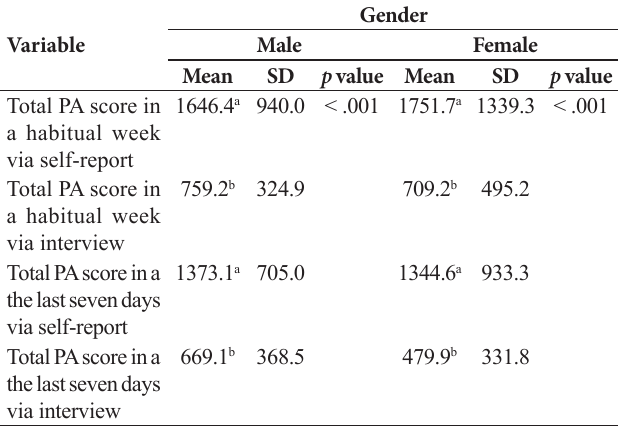
Table 3. Mean and standard deviation of the total PA scores (minutes/ week) measured according to the long version of the IPAQ, in a ha- bitual week and in the last seven days obtained via self-report and via trained interviewer, separated by gender ( n =38).